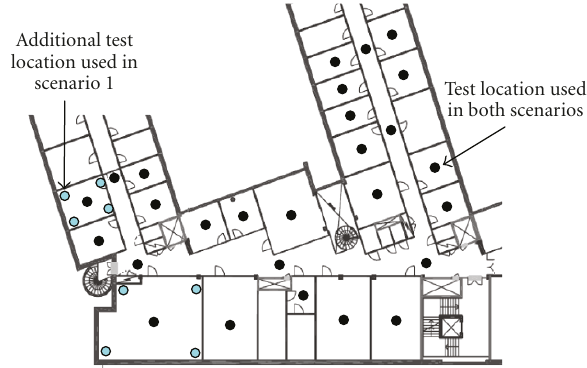
Figure 20: Test locations used in the experiments. Both scenarios included one test location per room and six test locations in the hallway (solid dots). For scenario 1, four additional test locations (open dots) in two rooms were recorded. This was done in order to find out the localization granularity by experimenting how small changes in real locations a ff ected the localization